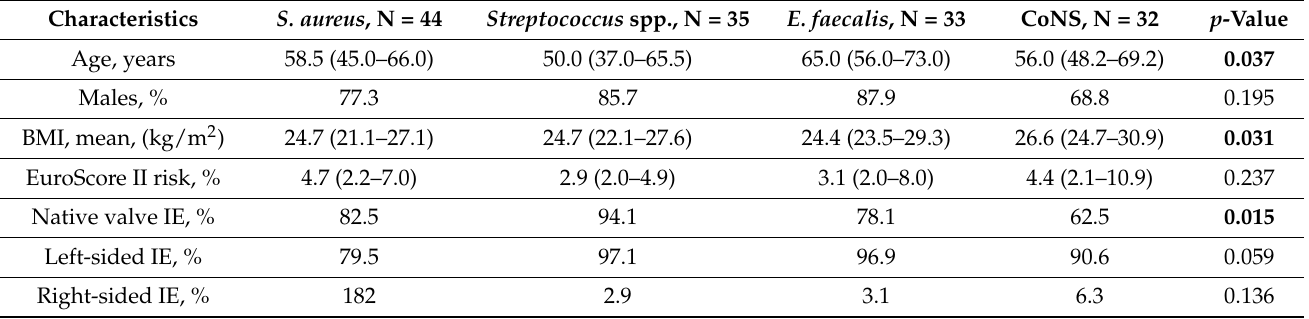
Table 1. Patients’ characteristics.